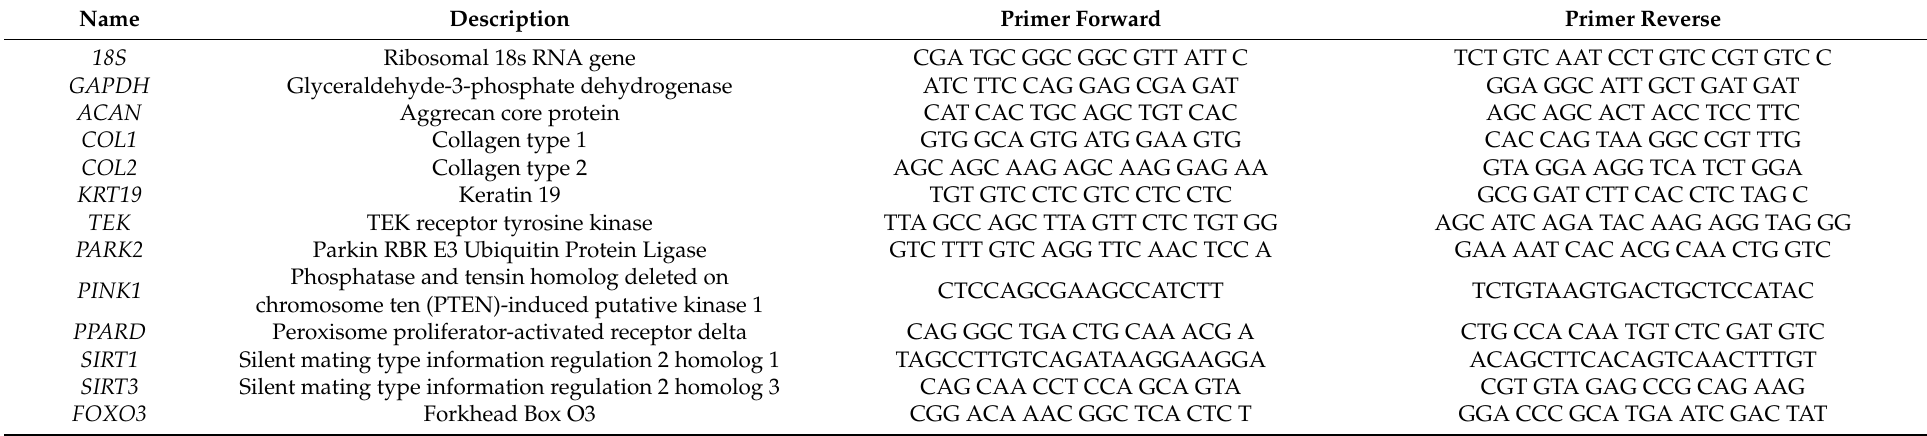
Table 2. Primers